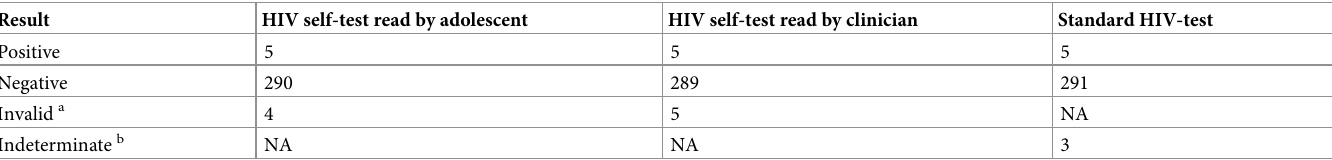
Table 3. Result of the oral HIV self-test and the confirmatory HIV